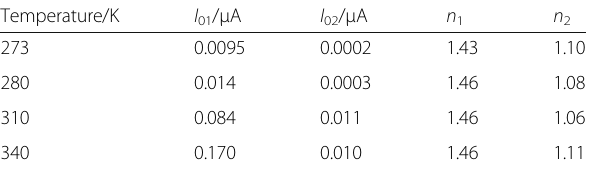
Table 1 Calculated ideality factor for ReSe 2 -Si and Si-Au contacts